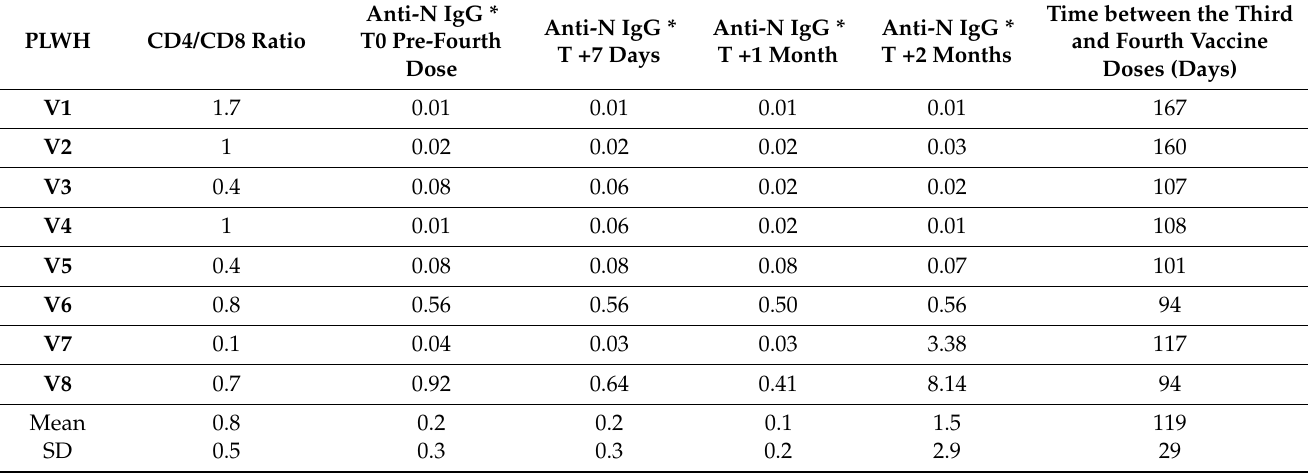
Table 2. Cellular ratio, measurement of anti-nucleoprotein IgG levels and time from the third dose administration of eight people living with HIV (PLWH), who received a fourth anti-SARS- CoV-2 mRNA vaccine dose . SD: standard